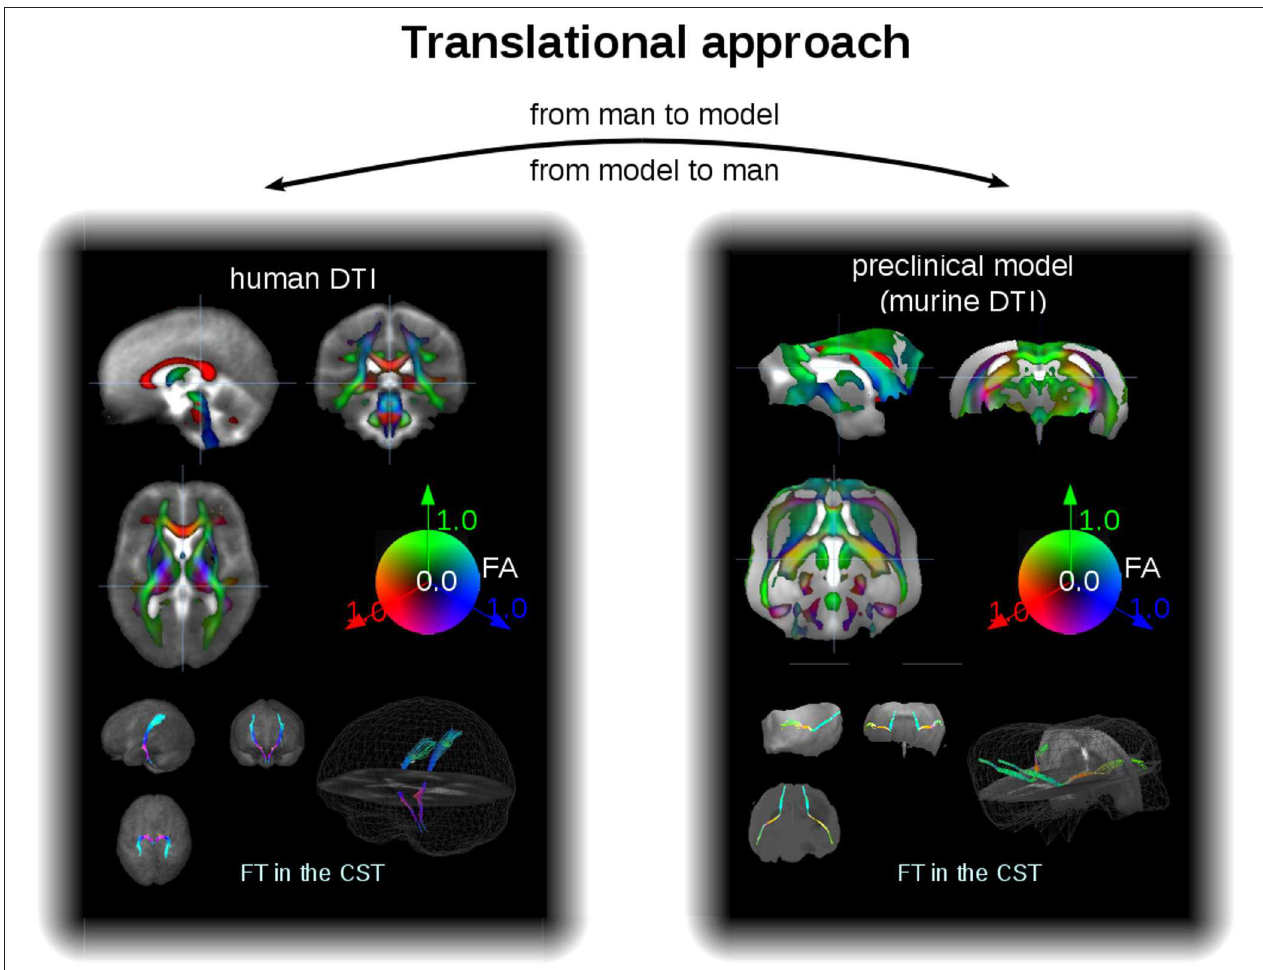
FIGURE 3 | Translational approach. In a different scale, DTI data of man and mice can be analyzed within the same software environment, that is, with the same analysis cascade. Examples for FA maps in coronar, sagittal, and axial orientation (upper panel) and projectional views of FT examples (lower panel) for human (left) and murine (right) group averaged data sets. The cerebellum of the mouse brains has been masked out. CST, corticospinal